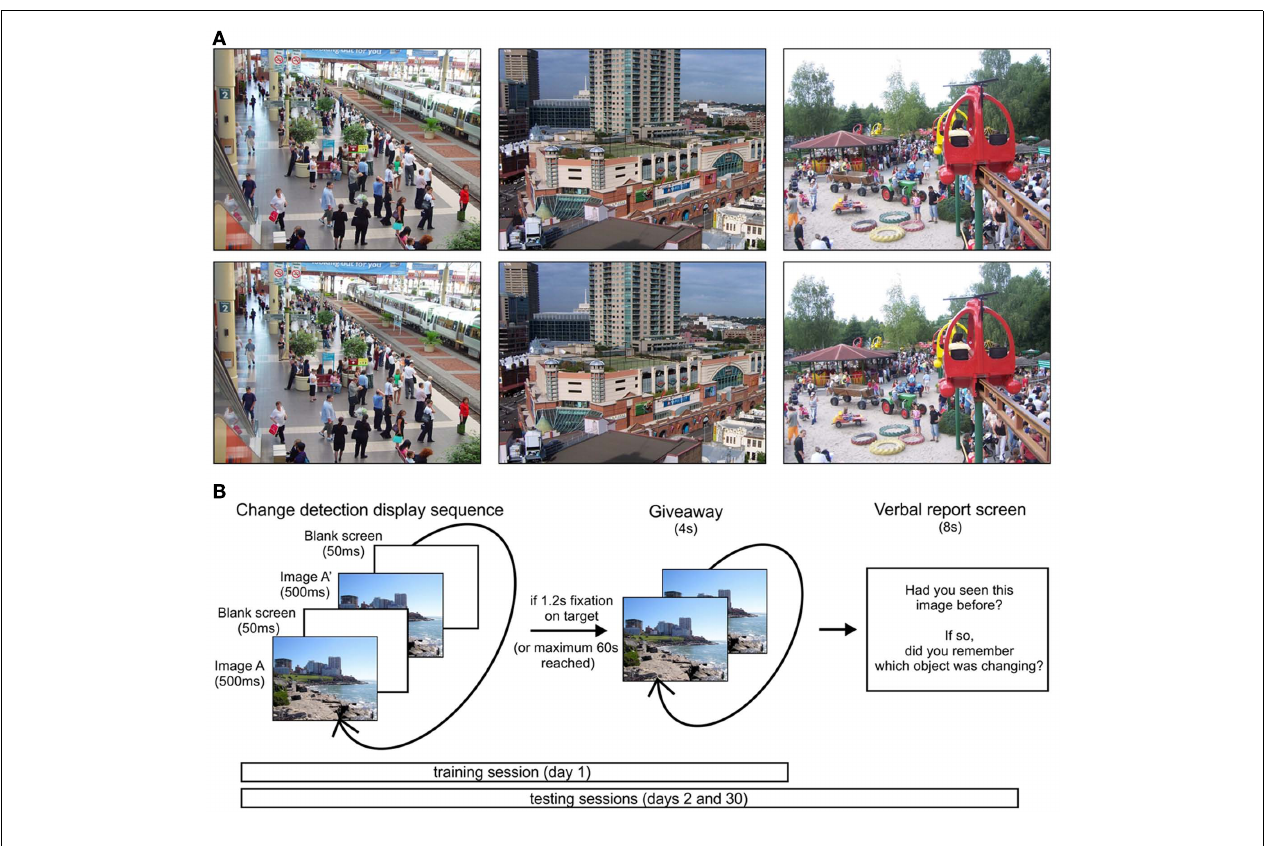
near tires in sand). (B) Trial sequence on training and testing sessions. During testing sessions, an additional verbal report screen was shown after each